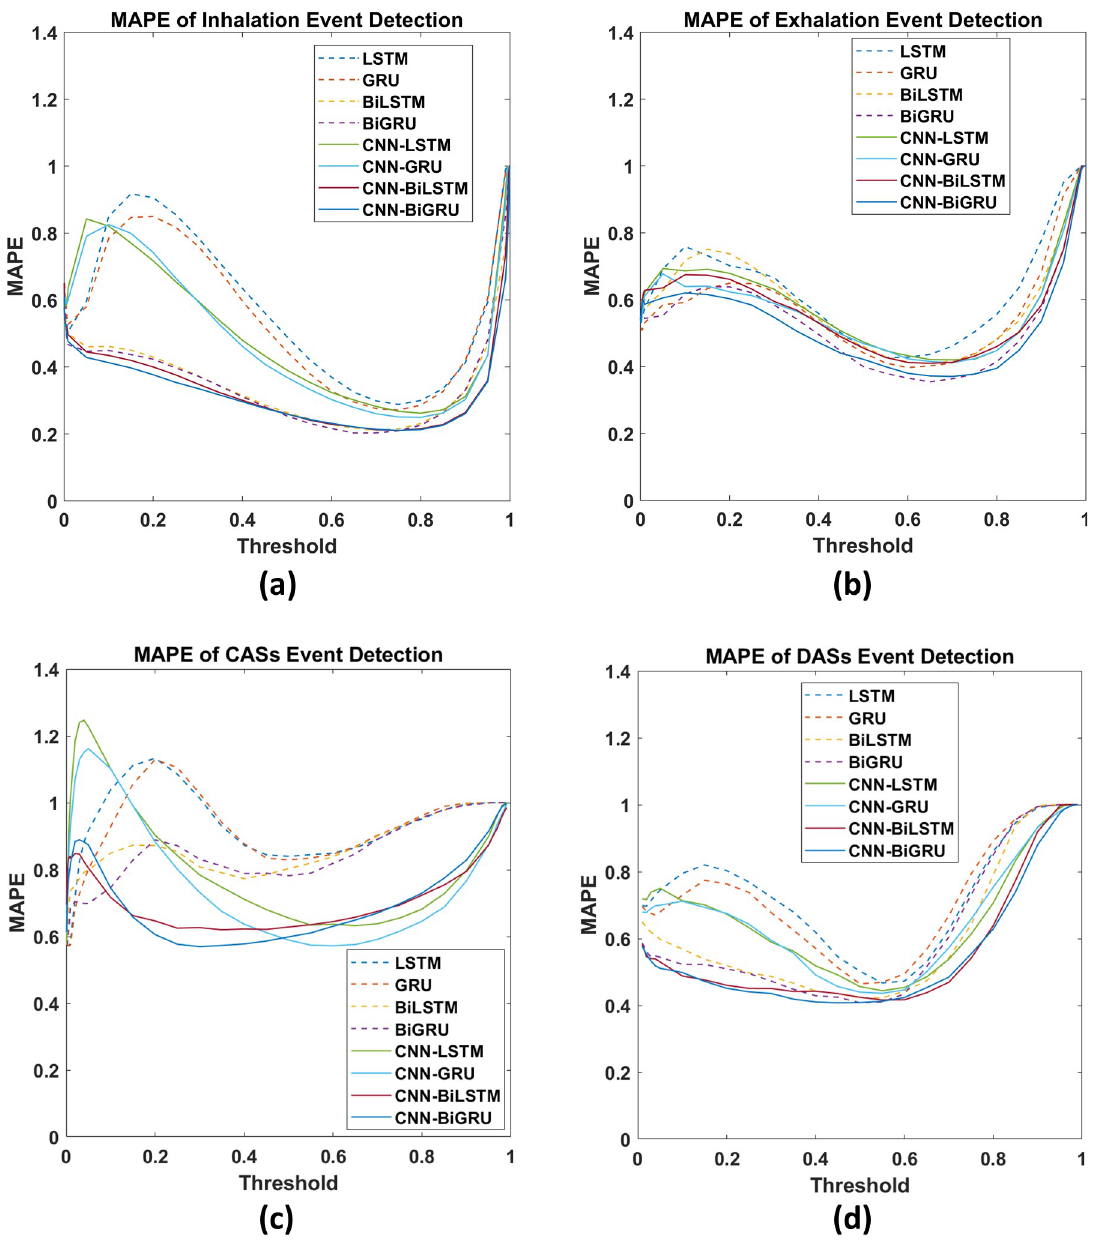
Fig 8. MAPE curves for (a) inhalation, (b) exhalation, (c) CAS, and (d) DAS event